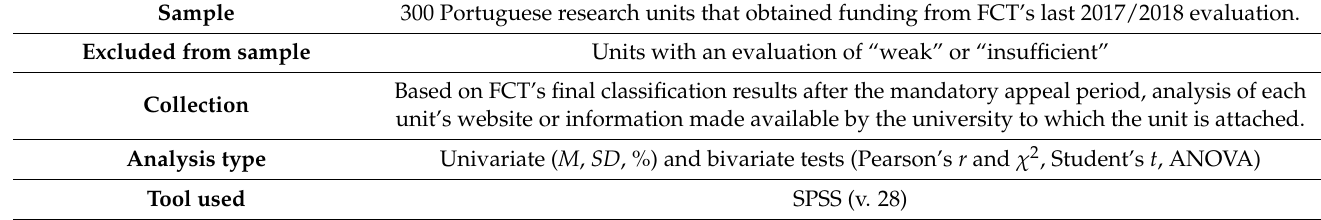
Table 1. Data collection